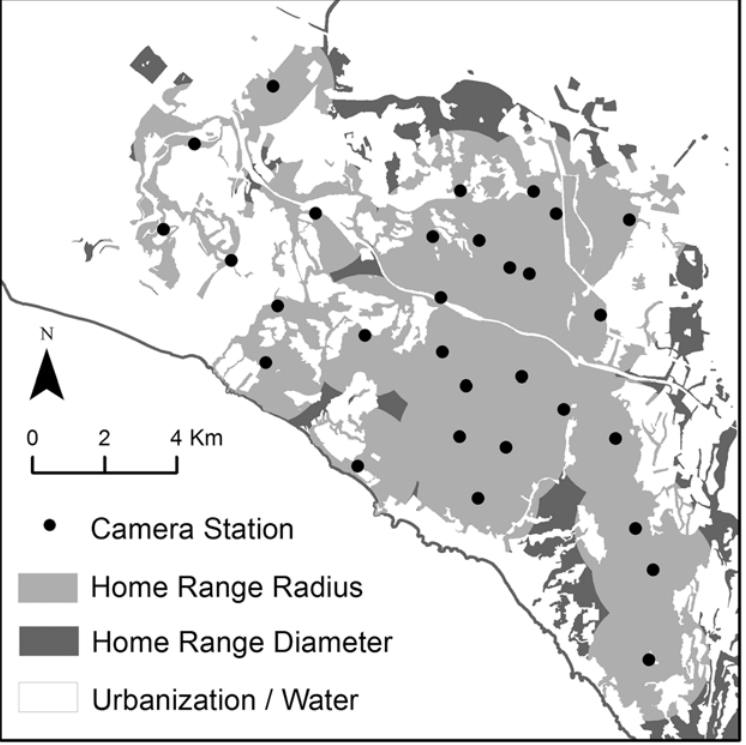
Fig 2. The effective study area using the radius and diameter of mean bobcat home range size (8.83 km 2 ) buffered around camera stations. Urban or water land use classifications [35] were removed from the buffers. Map figure base layer from SCAG [35] for representational purposes only.